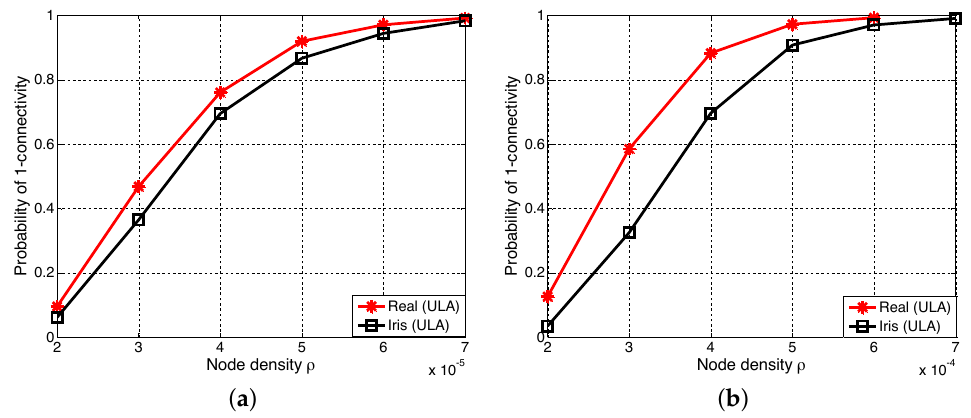
Figure 11. One-connectivity P ( 1-con ) of the ULA antenna and iris-ULA model. ( a ) α = 2.5, σ = 4; ( b ) α = 3, σ =